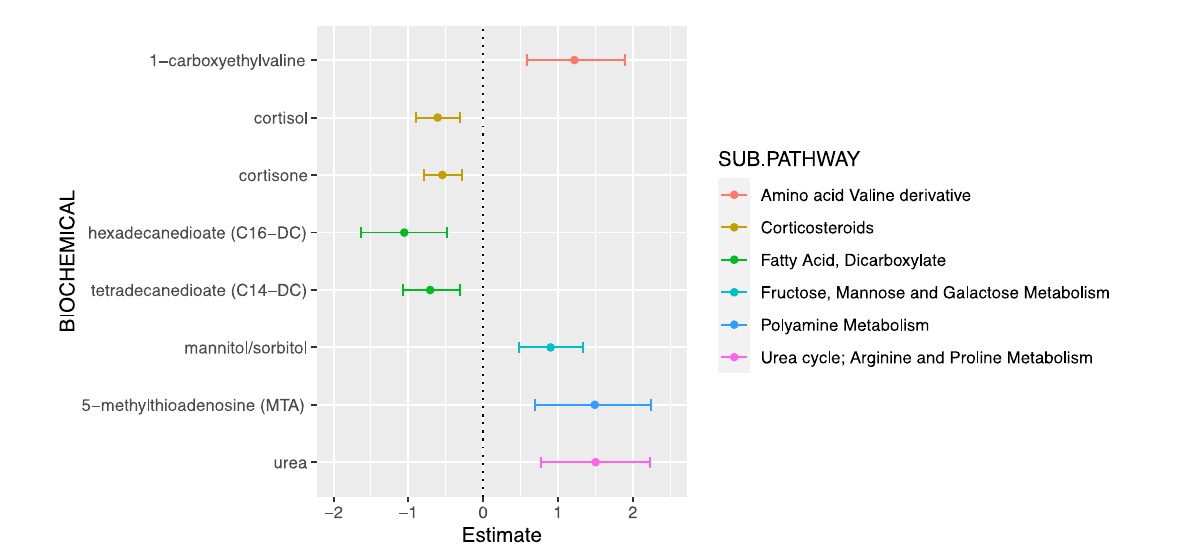
Figure 1. Metabolite (predictor) associations with exacerbation (outcome) in asthma cases with inhaled corticosteroid (ICS) intake at an “effective number of tests” (ENT) Bonferroni threshold p -value of 6.2 × 10 − 4 . The figure shows the effect/ β‐ estimates with confidence intervals on the x ‐ axis and metabolites on the y ‐ axis colored by their sub ‐ pathways in the legend key.